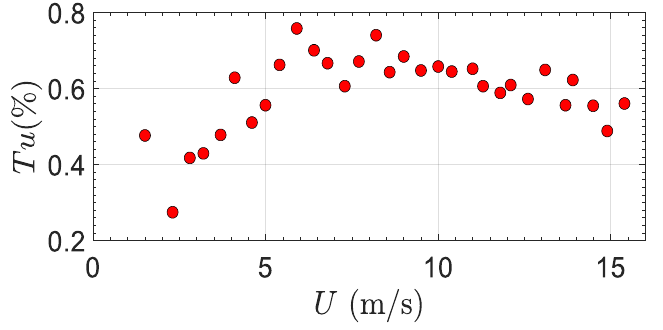
Figure 4. Turbulence intensity of the free-stream flow in the wind tunnel as a function of the wind speed.